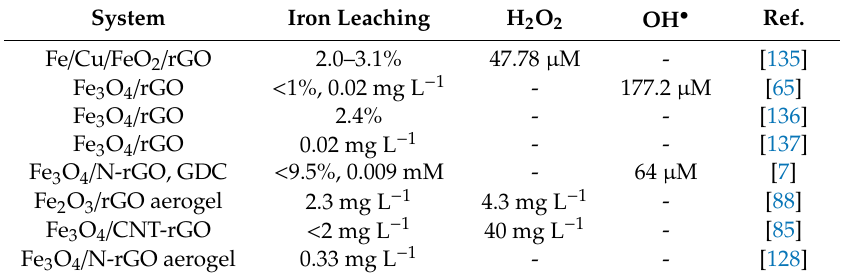
Figure 5. Pourbaix diagram for iron in water (dissolved iron concentration is 1.0 × 10 − 5 M at 298 K). Only Fe, Fe 3 O 4 , Fe 2 O 3 are considered as the solid products, generated with the MEDUSA software based on the SOLGASWATER algorithm [134]. Table 3. Leaching rates of iron from iron-containing graphene-based composites.